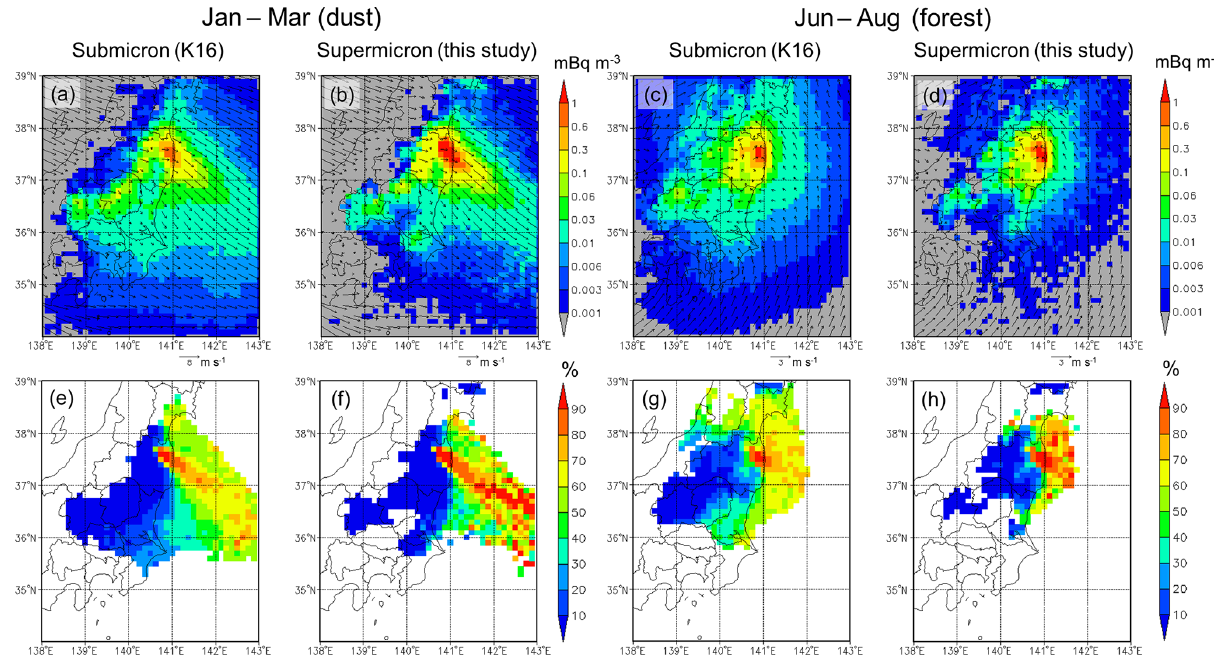
Figure 5. (Top panels) Seasonal mean surface concentrations of (a, c) submicron (K16; E c and v d are 0.04 and 0.1cms − 1 , respectively) and (b, d) supermicron (this study; E c and v d are 0.4 and 10cms − 1 , respectively) 137 Cs associated with (a, b) dust aerosols in winter to early spring (January, February, and March) and (c, d) forest aerosols in summer (June, July, and August) (mBqm − 3 ). The seasonal mean surface wind vectors are also depicted in the panels. (Bottom panels) Same as top panels but for the fractional contributions from the resuspension source area (defined as the initial depositions of 137 Cs exceeding 300kBqm − 2 ; see Fig. 1b) to the surface concentrations (%).